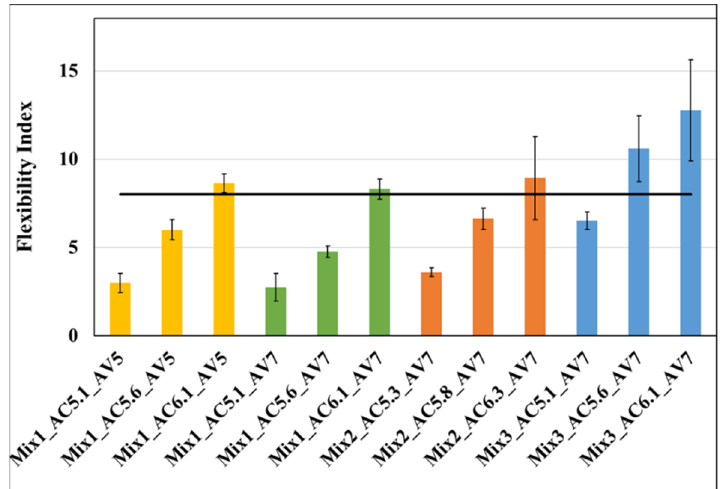
Figure 2. FI test results for all mixtures at 25 °C (length of the error bar is equal to one standard deviation). The number after AC indicates the percent asphalt (or binder) content. The number after AV represents the percent air voids of the samples.